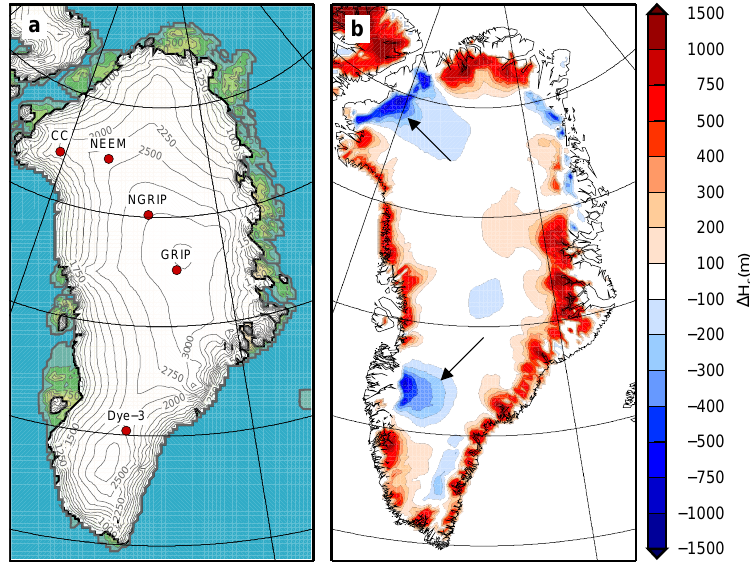
Fig. 13. (a) Ice sheet elevation and (b) difference with present-day observed elevation after the glacial cycle experiment.